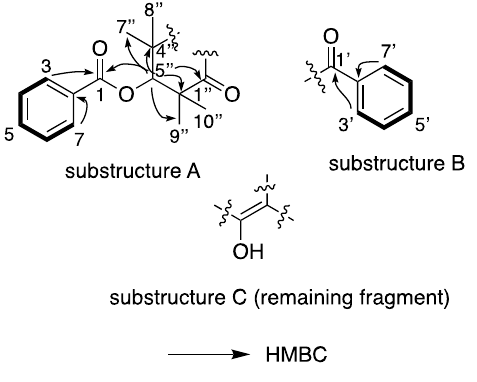
Figure 1. Diagnostic (600 MHz, CD 3 OD) HMBC and COSY correlations of 1.